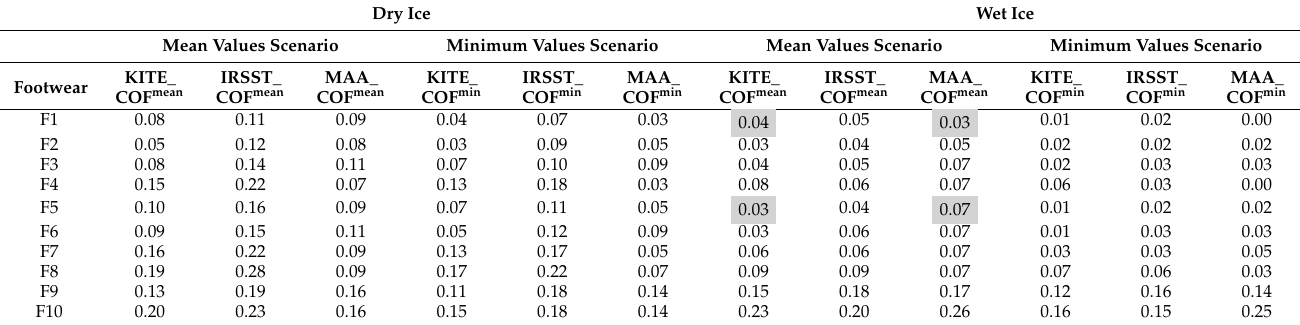
Table 3. COF values for all footwear obtained from different methods and ice conditions. Dry Ice Wet